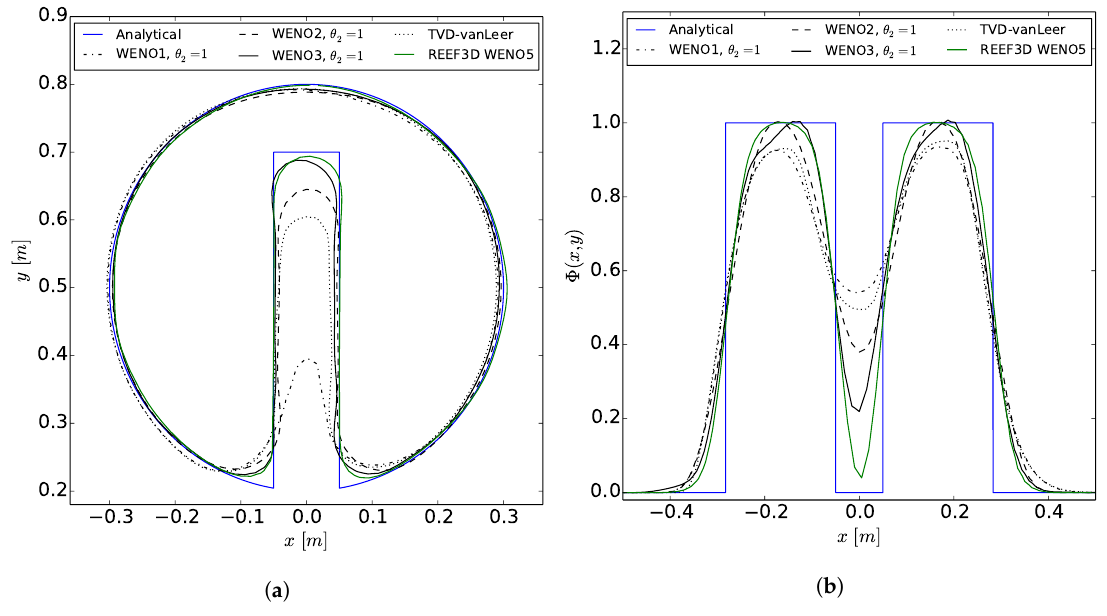
Figure 17. Results of convection schemes for Zalesak’s disk on 128 Φ = 0.5; ( b ) slice of the disk at y = 0.6 m.